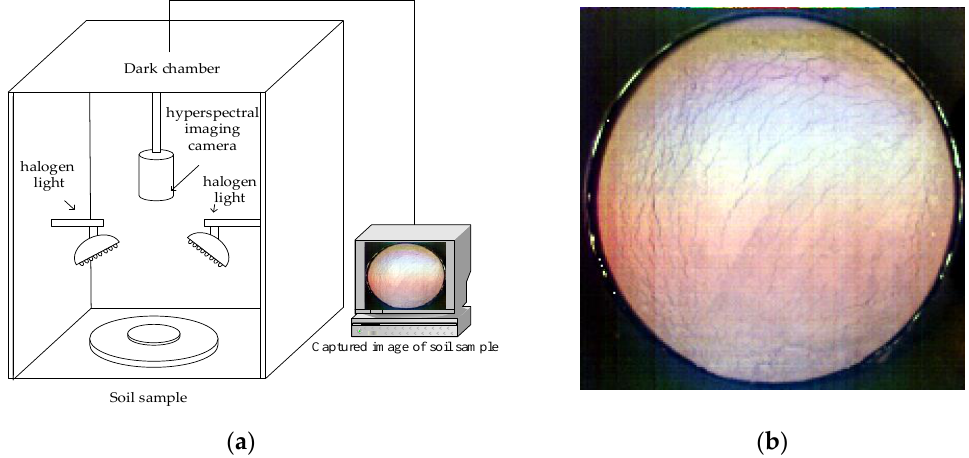
Figure 1. ( a ) Hyperspectral imaging setup. ( b ) Acquired imagery (R: 640 nm, G: 548 nm, B: 470